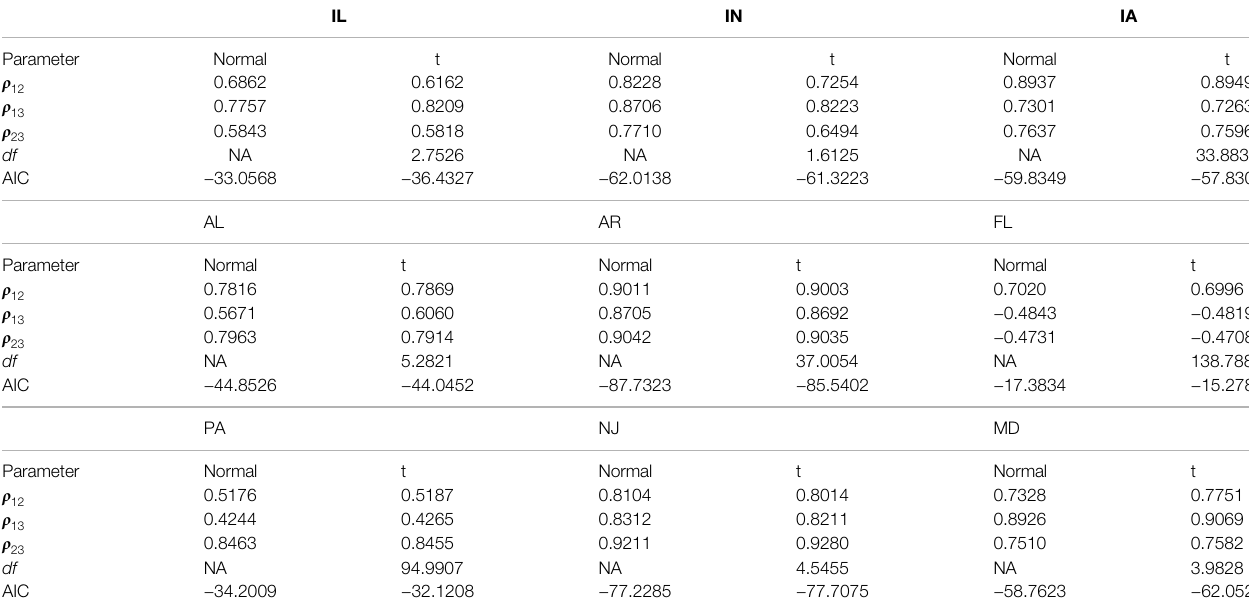
TABLE 3 | Elliptical (Normal and t) copula estimation results for the nine datasets.